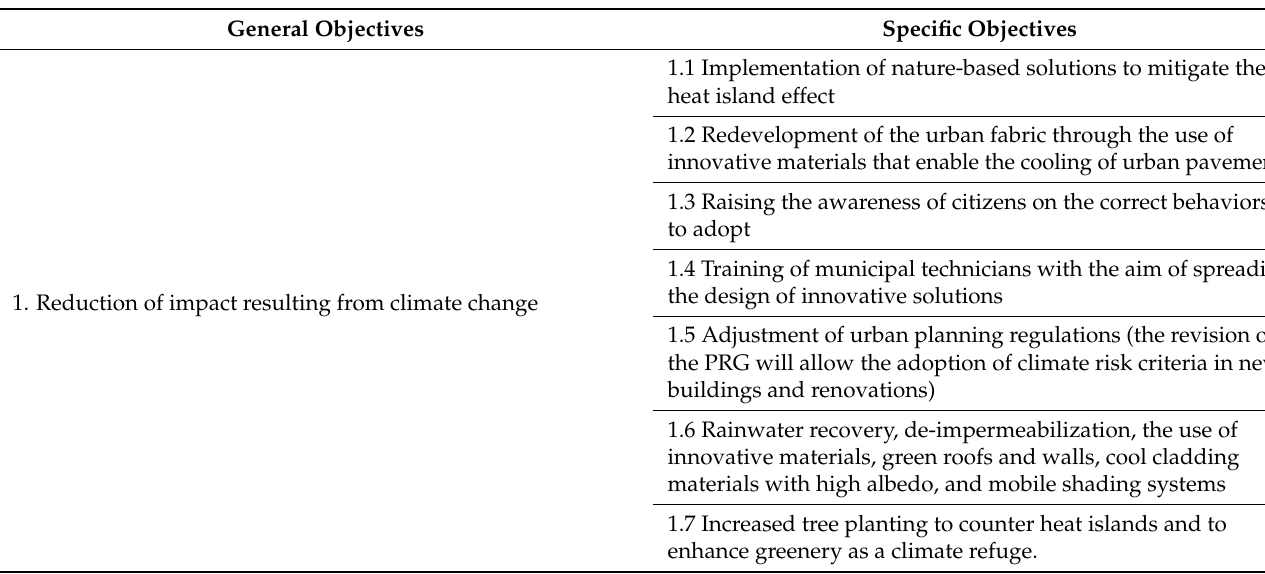
Table 16. Strategic framework of the City’s Climate Resilience Plan [53].